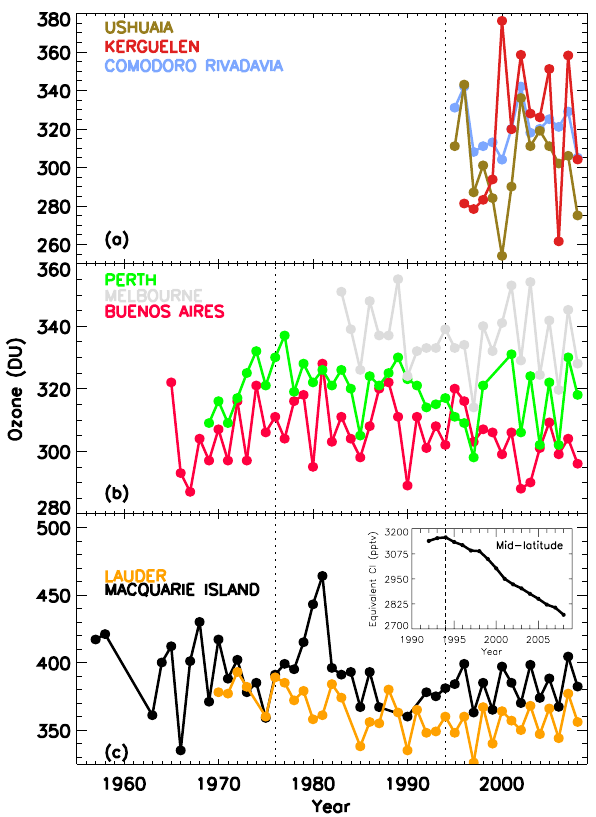
Fig. 10. Evolution of October mean total ozone from southern mid-latitude ground-based stations (a) stations installed after 1985, (b) historical stations at 30–40 ◦ S, and (c) historical stations at 40– 60 ◦ S with equivalent chlorine in the mid-latitude in the inset. The dotted vertical lines represent years 1976 and